Question: Based on the figure, does the quantity rise or fall?
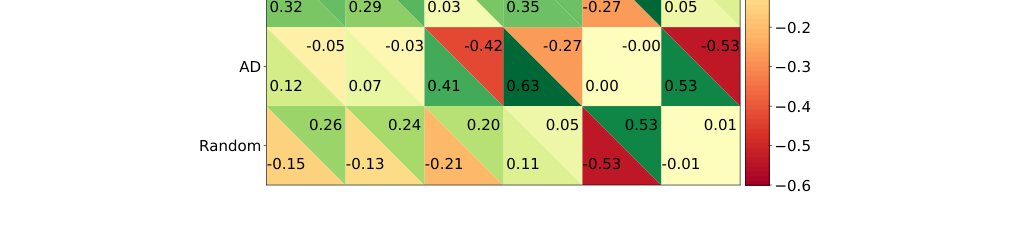
Answer: increasing